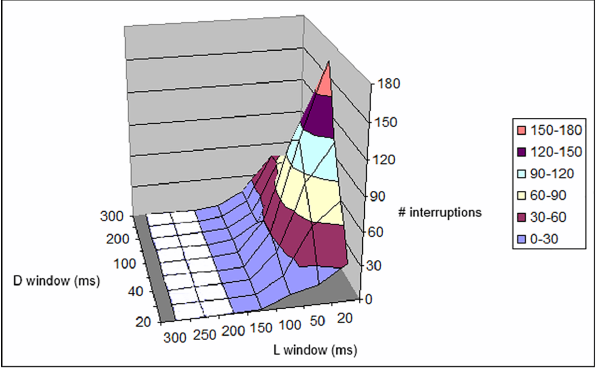
Fig 12. Plot of data given in Table 4. Number of interruptions with respect to L window and D window length, for a 5,000-ms period at 5,000 photons/s and a threshold of 8, as reported in Table 4.